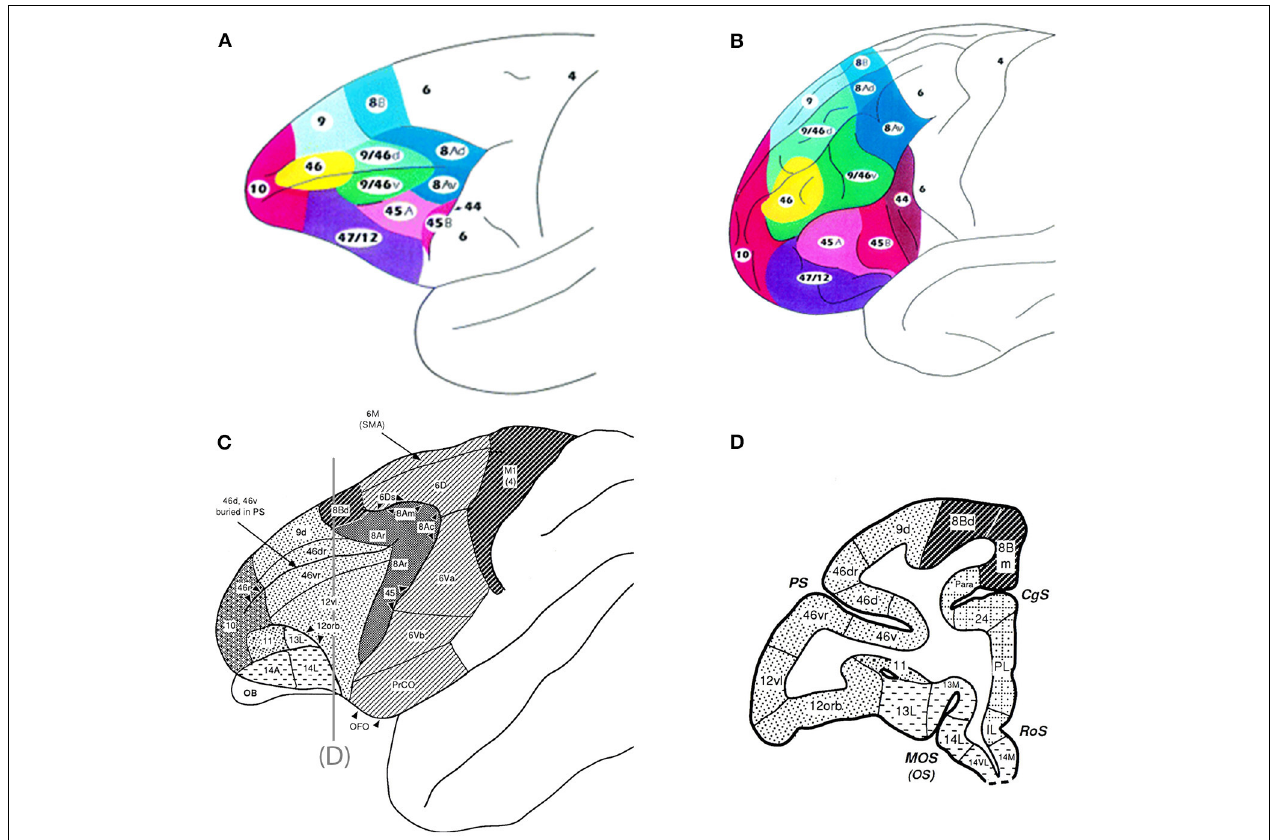
FIGURE 1 | Top panel are schematics of the lateral and frontal surfaces of the monkey (A) and human (B) brain from Petrides and Pandya (2002). Bottom panel are schematics illustrating area 12vl (now referred to as 12/47) and 12 orb (C) and a coronal section (D) depicting these regions from Preuss